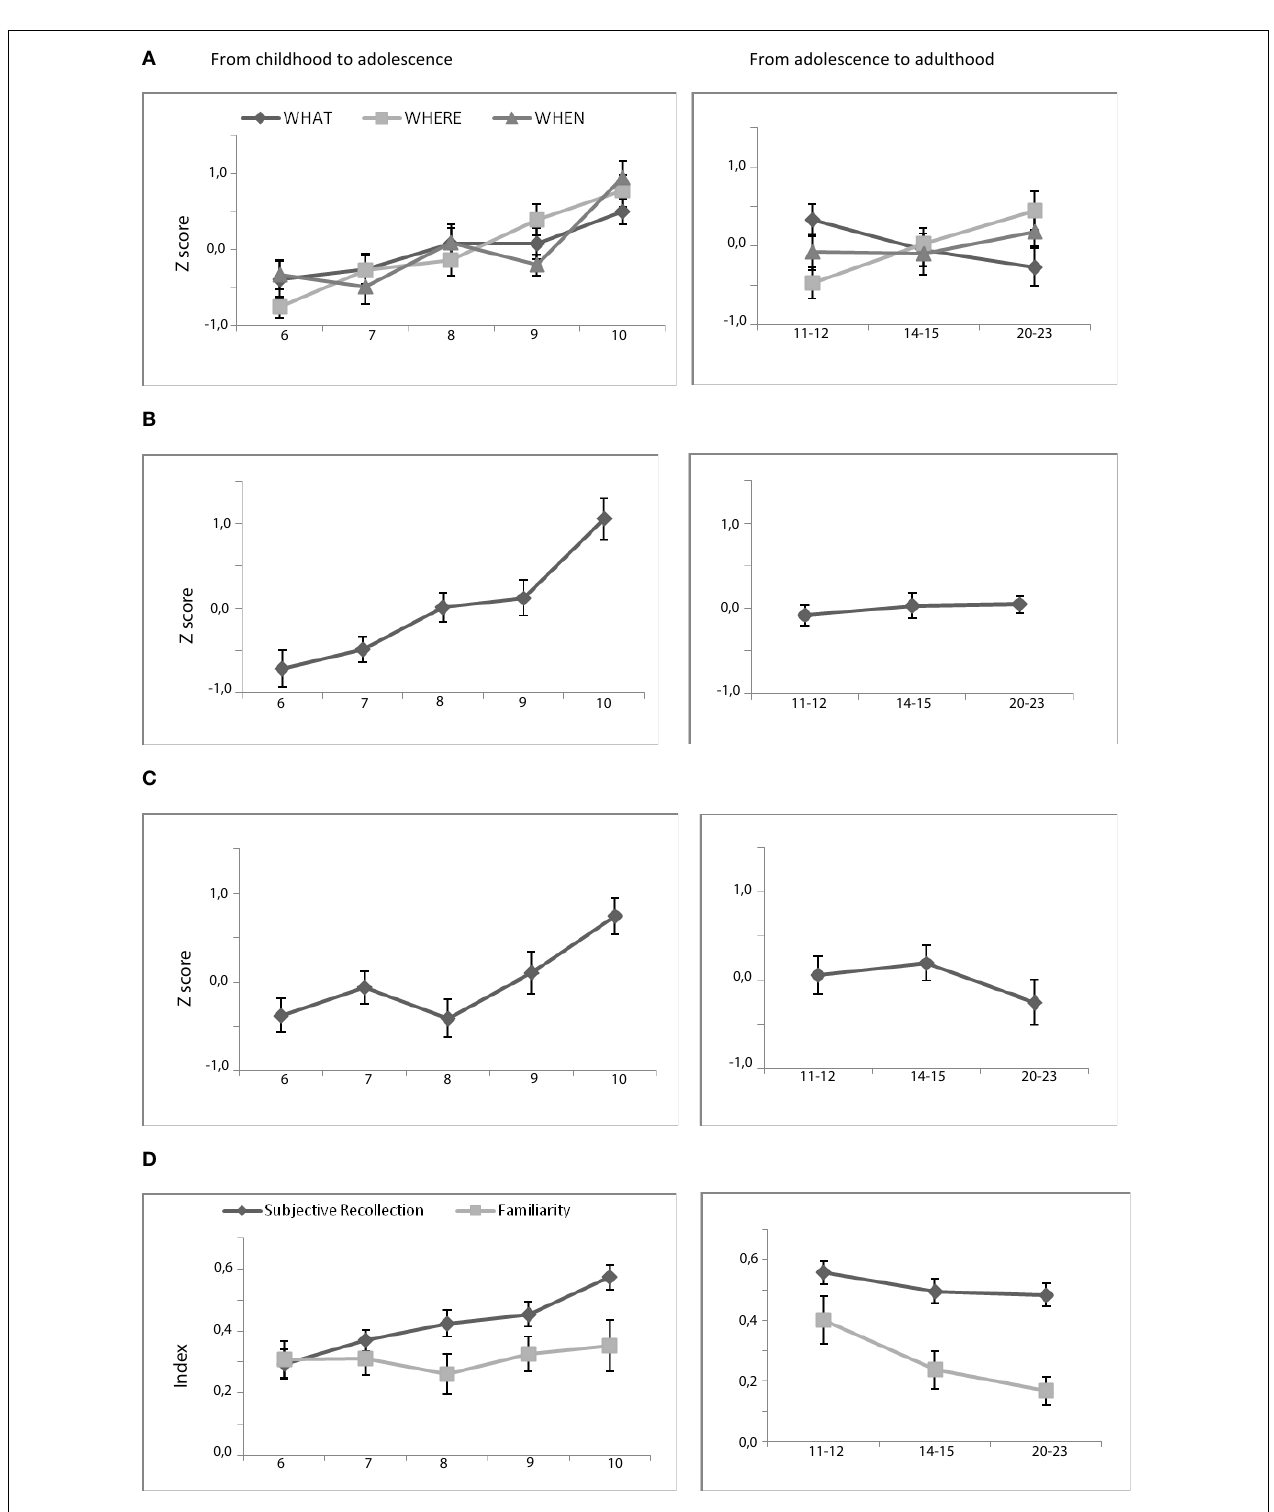
FIGURE 2 | Behavioral performances on the associative memory tasks . (A) Mean performance of associative cued recall (hits) for each memory task as a function of age. (B) Mean episodic score. (C) Mean objective recollection. (D) Mean subjective recollection and familiarity index.